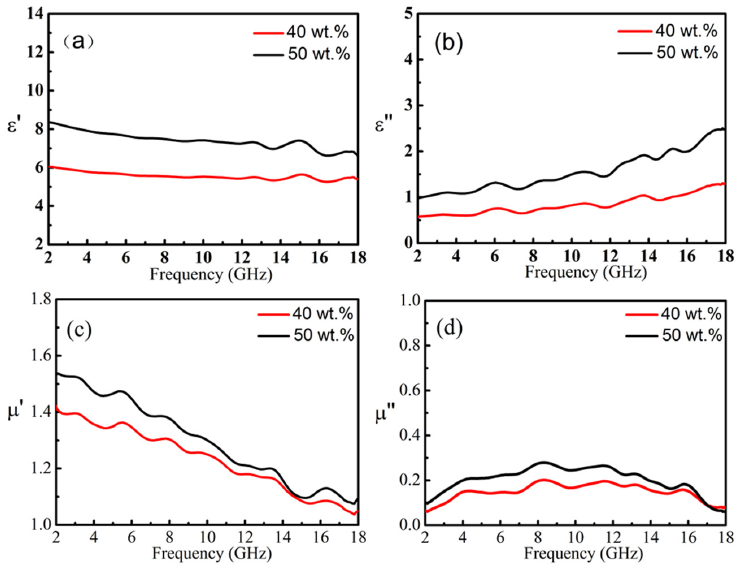
Figure 4. The ε (cid:48) ( a ), ε (cid:48)(cid:48) ( b ), µ (cid:48) ( c ) and µ (cid:48)(cid:48) ( d ) for Fe@C /paraffin composites containing 40 wt.% and 50 wt.%, respectively.